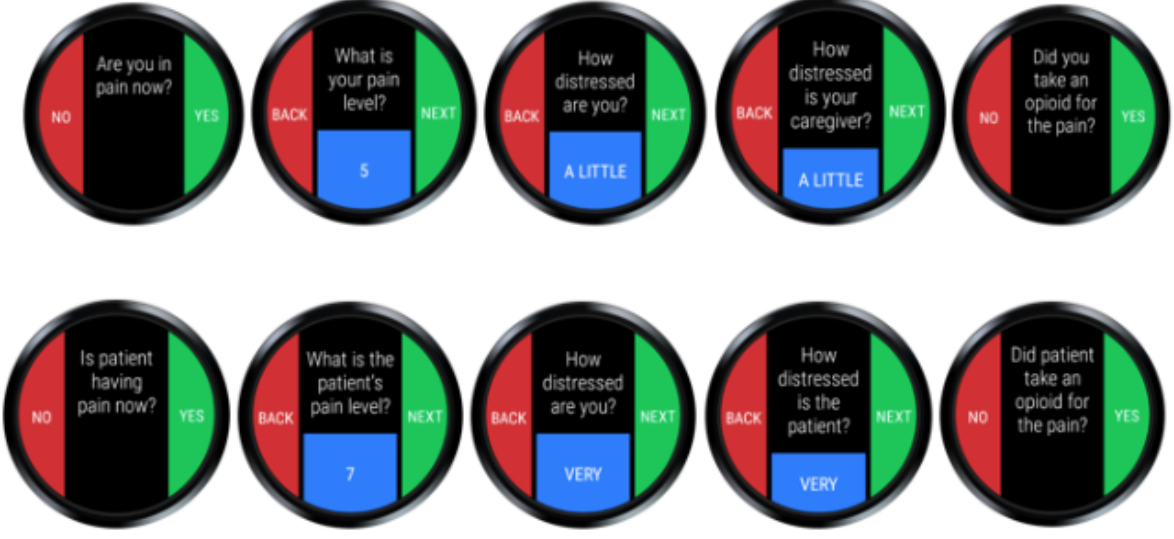
Figure 5. The Behavioral and Environmental Sensing and Intervention for Cancer system architecture for active data collection, examples of smart watch ecological momentary assessments for patient pain events (top), and caregiver pain events (bottom). See Multimedia Appendix 1 for more